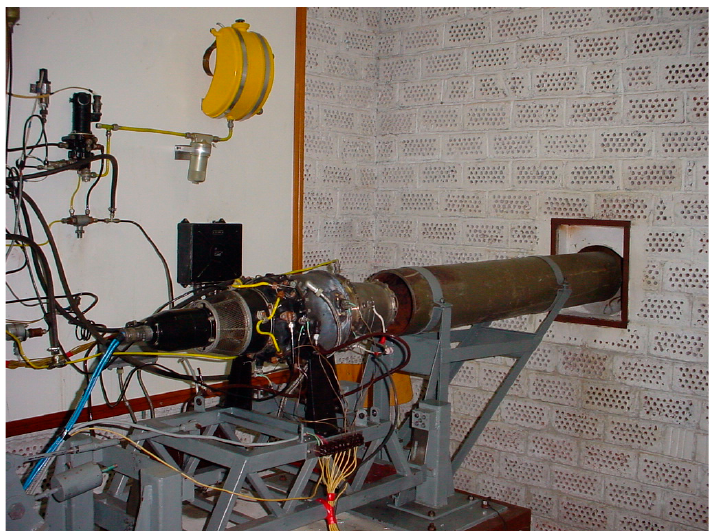
Figure 3. Small jet engine lab .